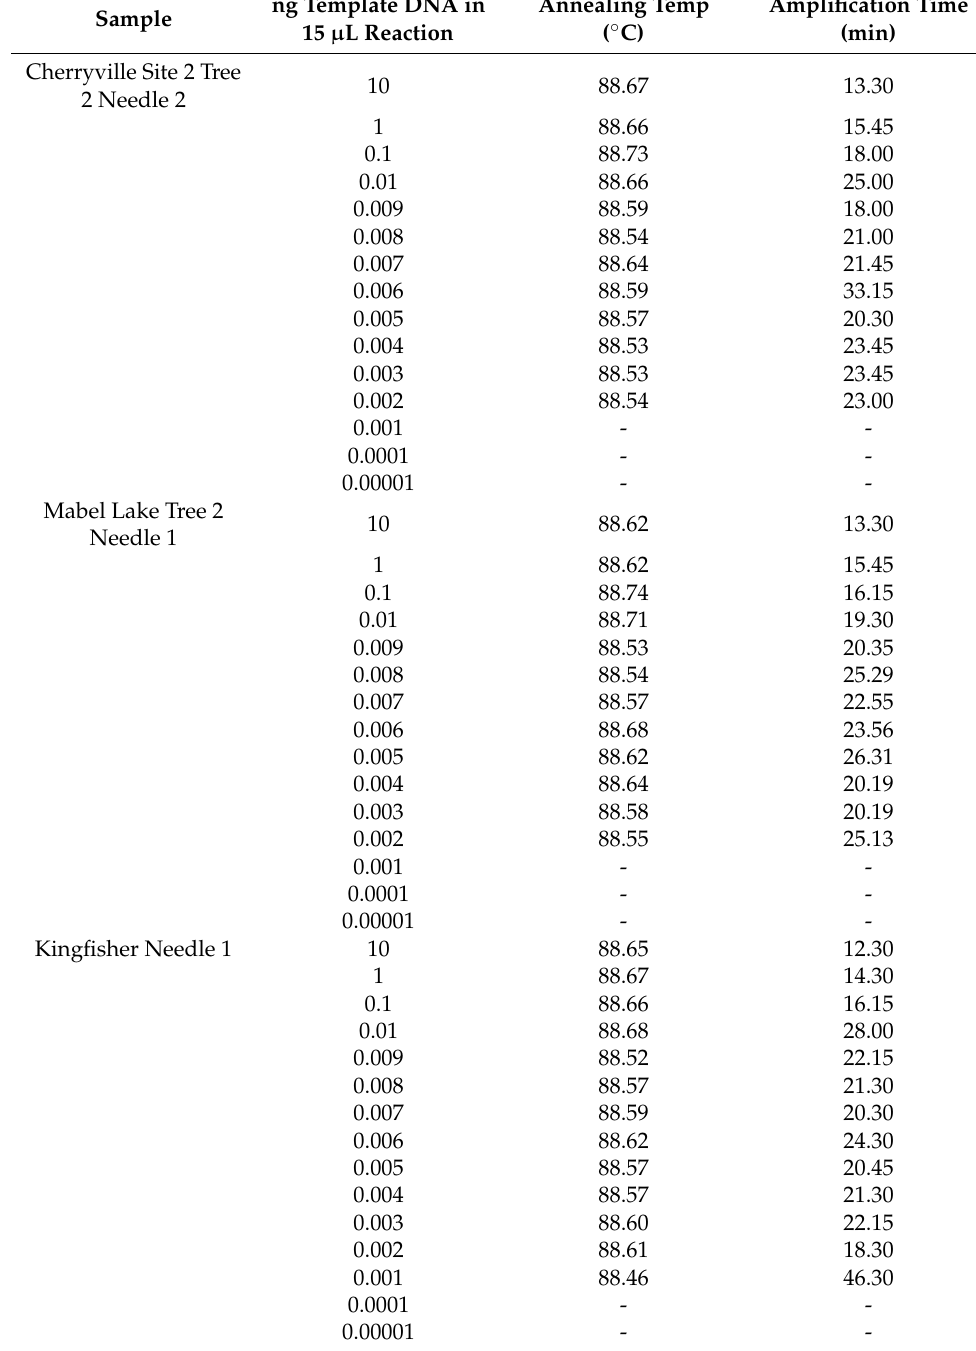
Table 3. Sensitivity of LAMP assay determined by using serial dilutions of D. septosporum